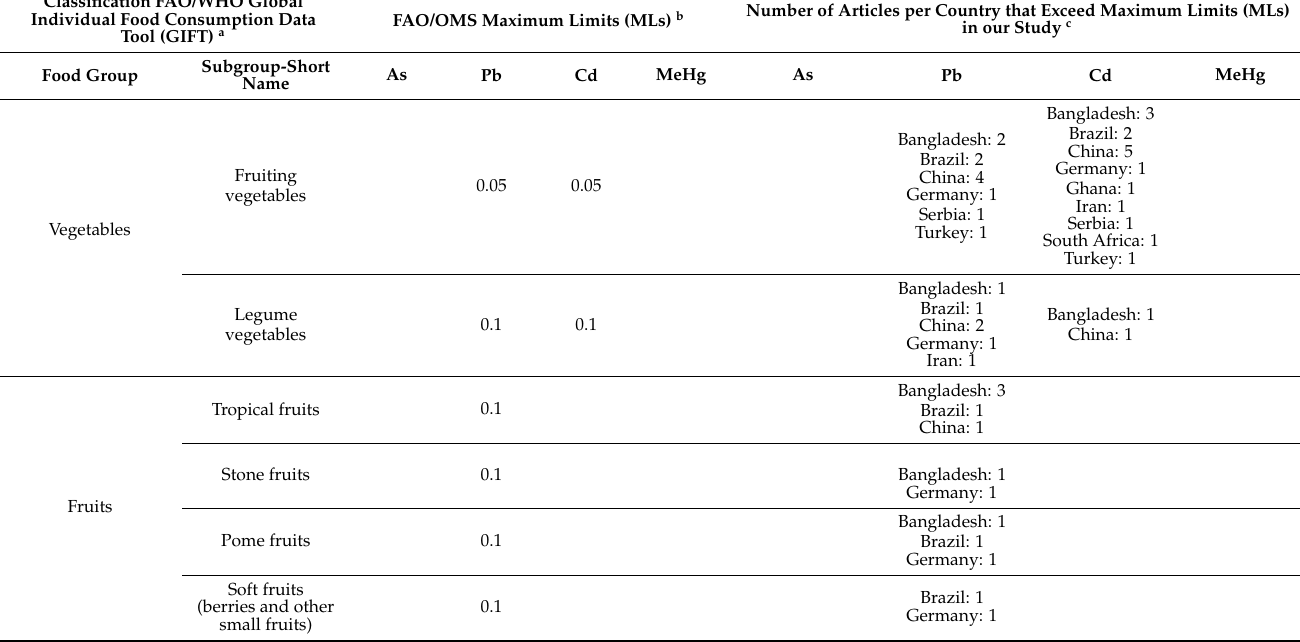
Number of Articles per Country that Exceed Maximum Limits (MLs) in our Study